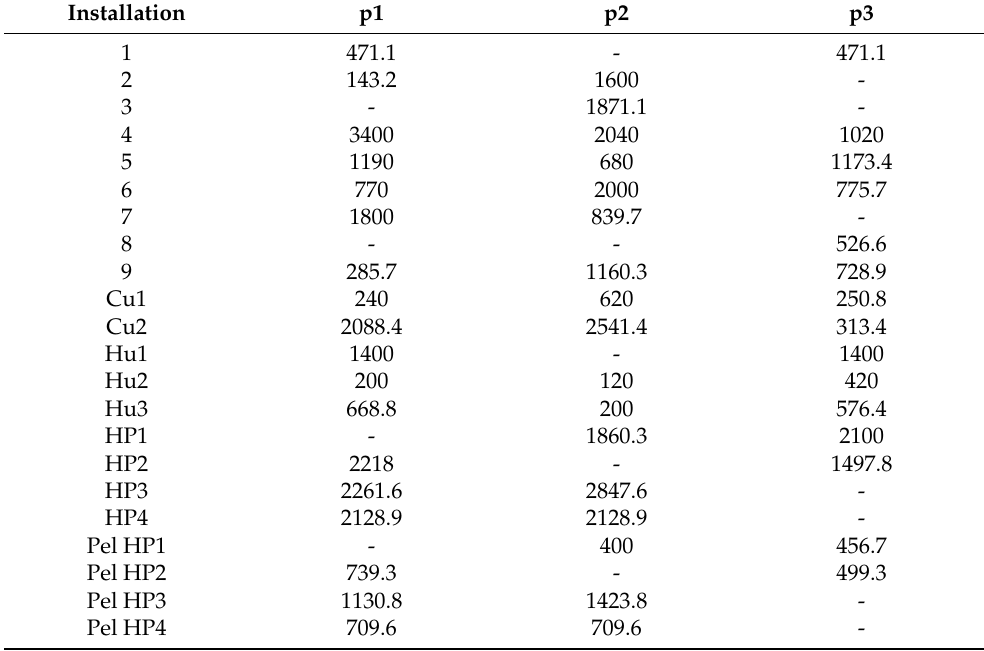
Table 12. Heat Flows and P el results with HP and ST options case 4